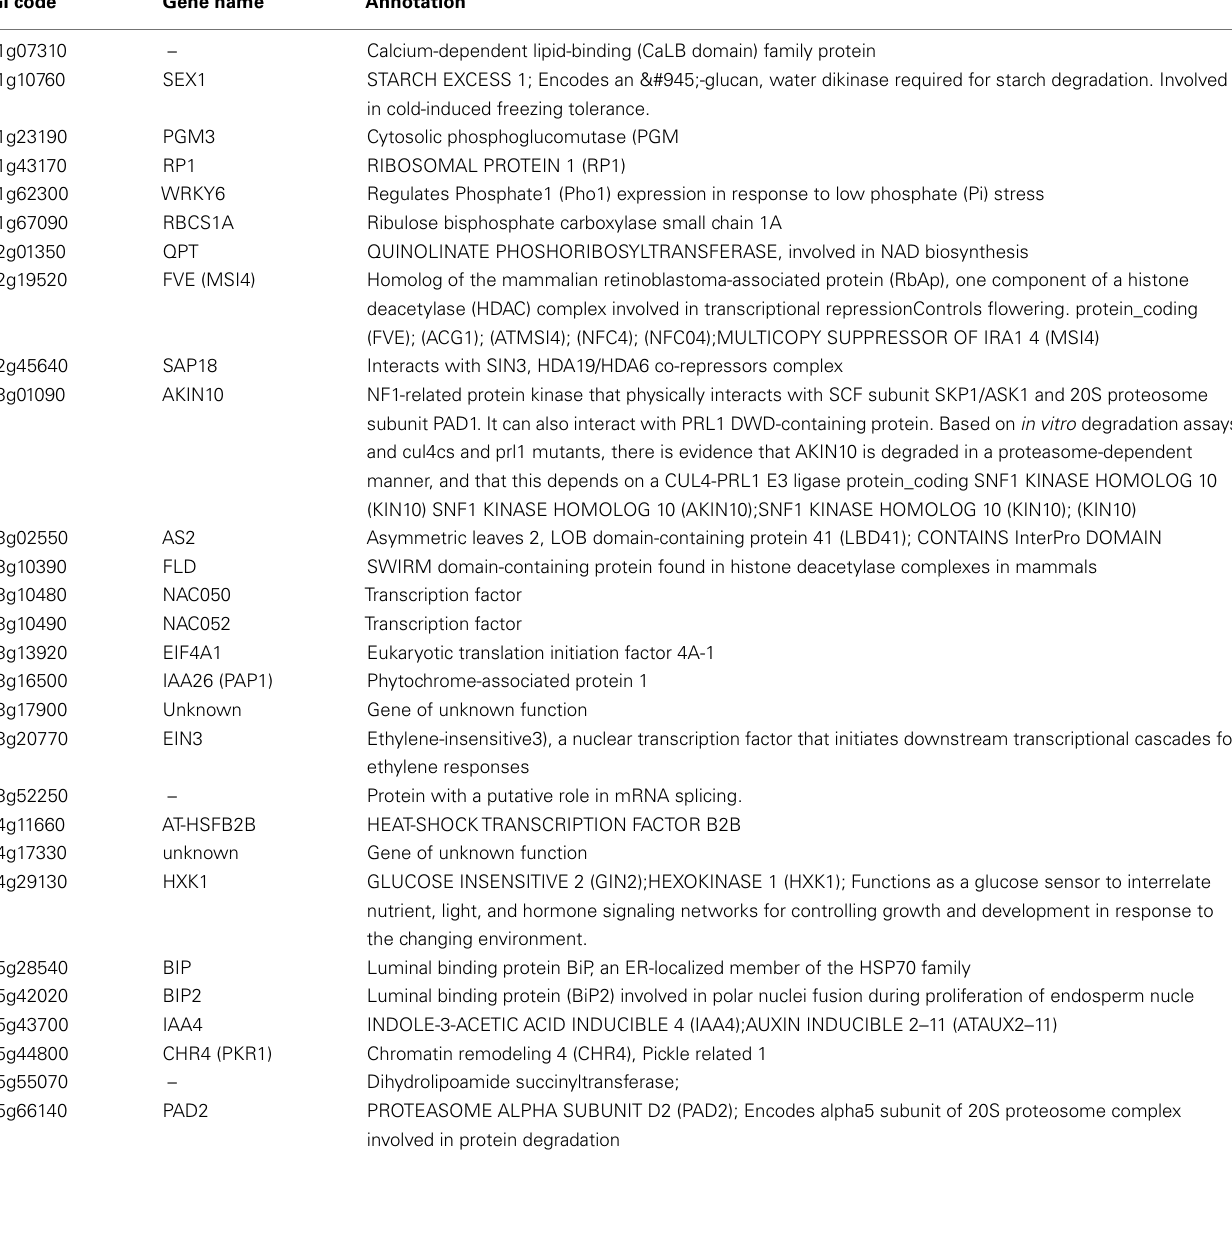
TableA1 |The overlap between the SUMO interactome and proteins that interact with topless (TPL) andTPL-related 1–4 fromArabidopsis. AGI